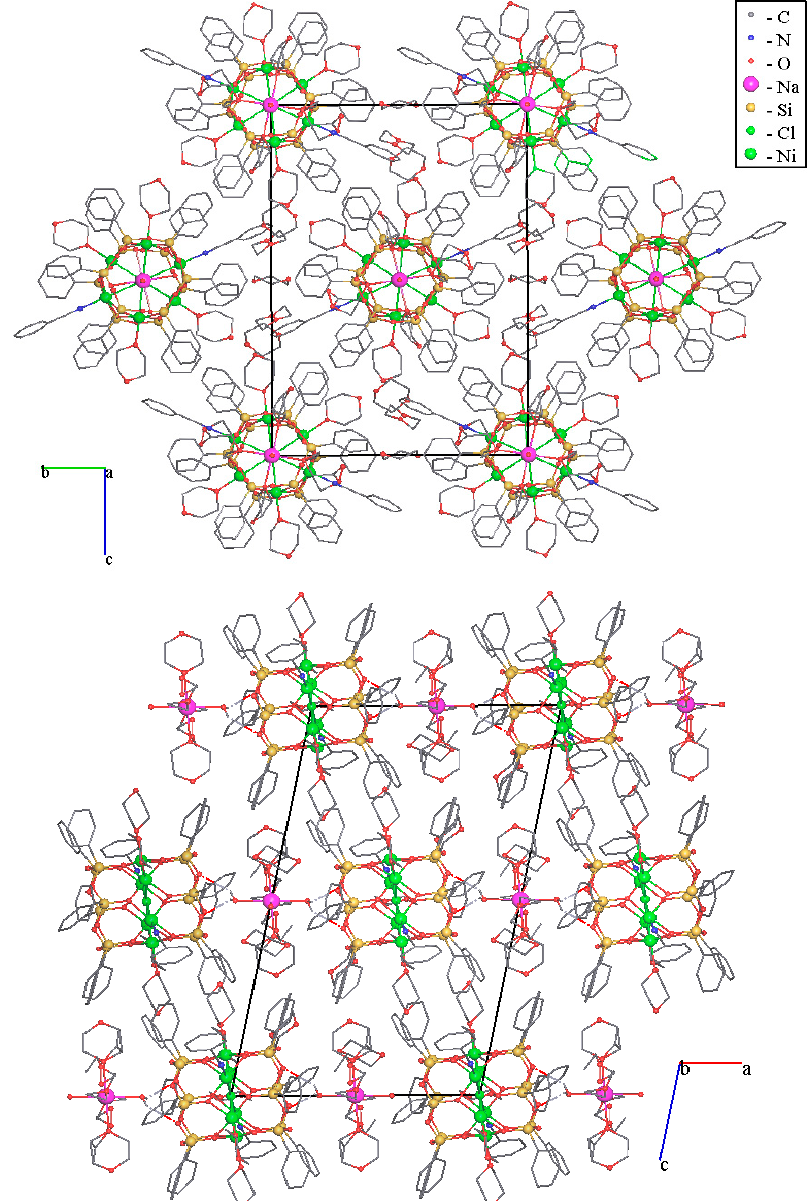
Figure 3. Crystal packing of 1 .